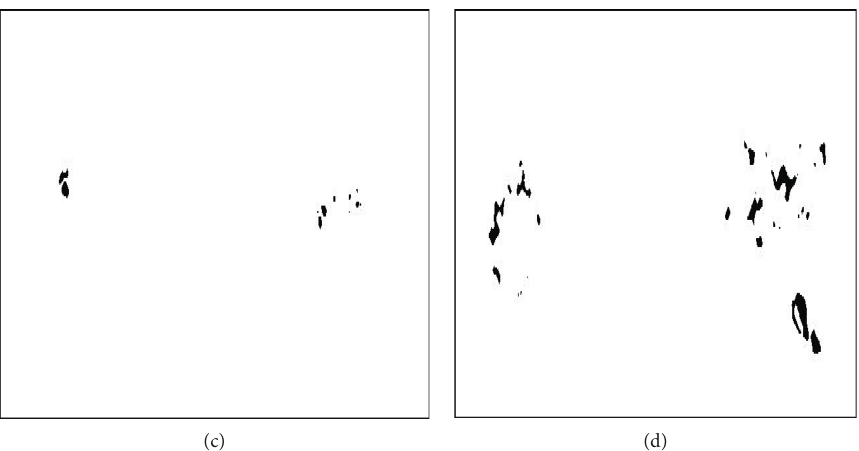
Figure 9: Image 6 segmentation results: (a) original image, (b) grayscale image, (c) segmentation results using Canny, and (d) segmentation results using our